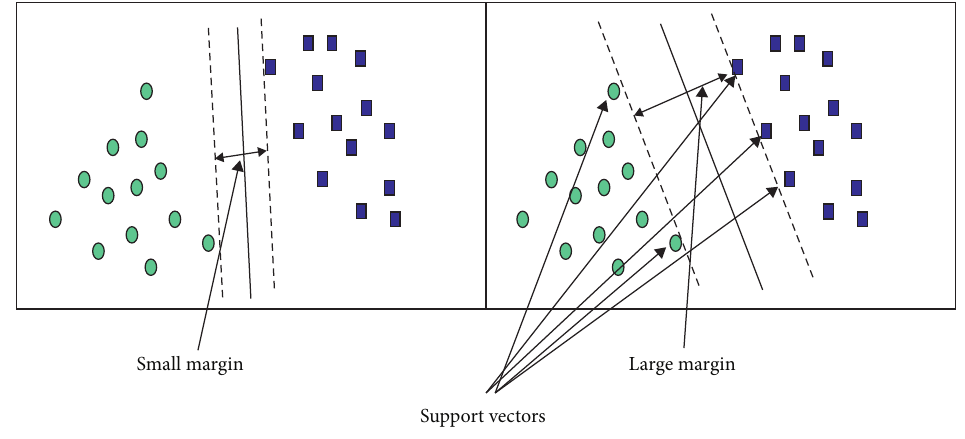
Figure 9: Support